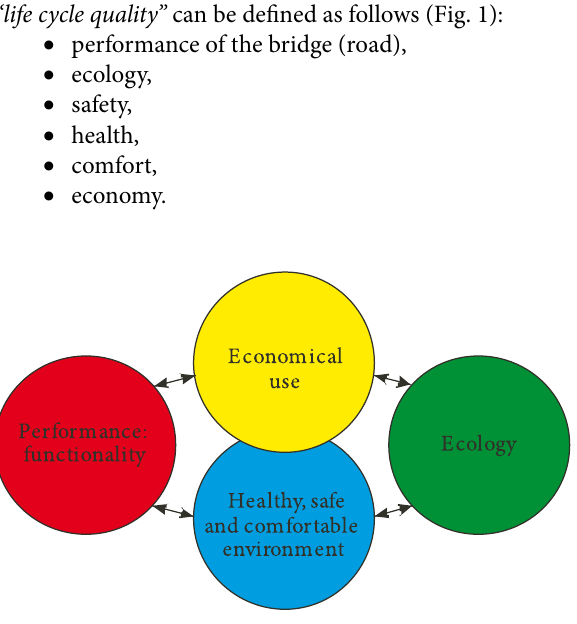
Fig. 1 . Main aspects of the detailed road life cycle – quality design